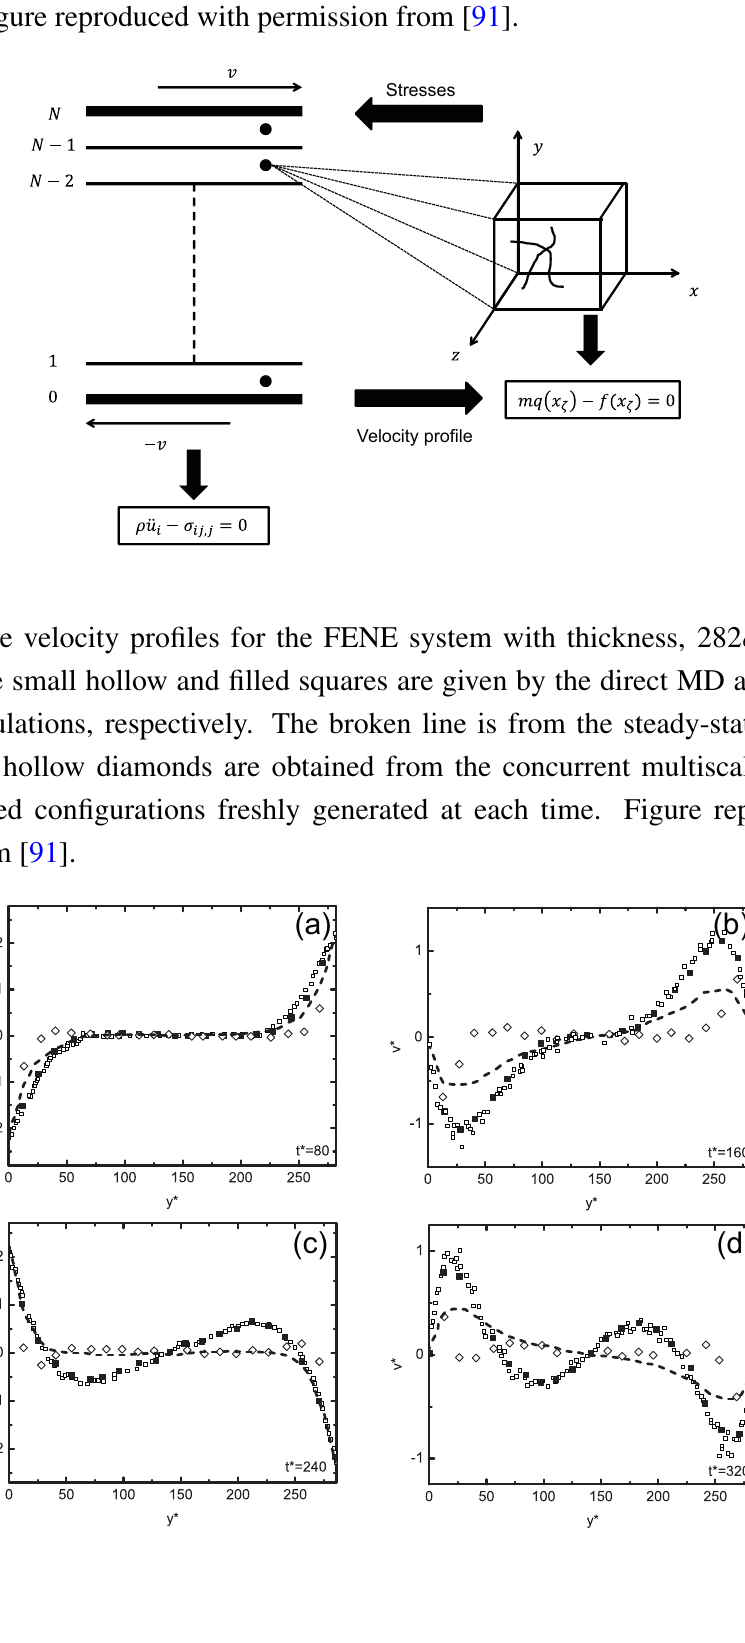
Figure 21. Description of the setup of the concurrent multiscale modeling method. The stresses calculated from MD simulations are passed into continuum simulation, while the velocity profile obtained from continuum simulations is used for the next set of MD simulations. Figure reproduced with permission from [91].